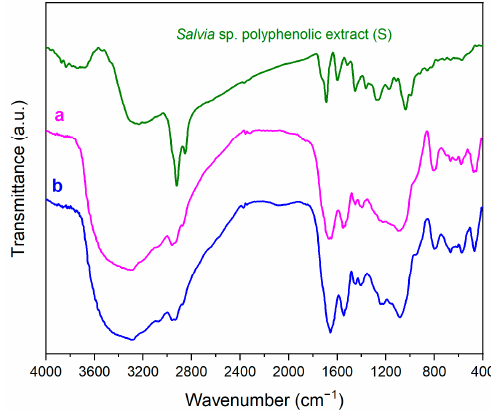
Figure 10. FTIR spectra of collagen − polyphenols-loaded MSN composites: collagen − S@MSN − COOH (a) and collagen − S@MSN − NH 2 (b).